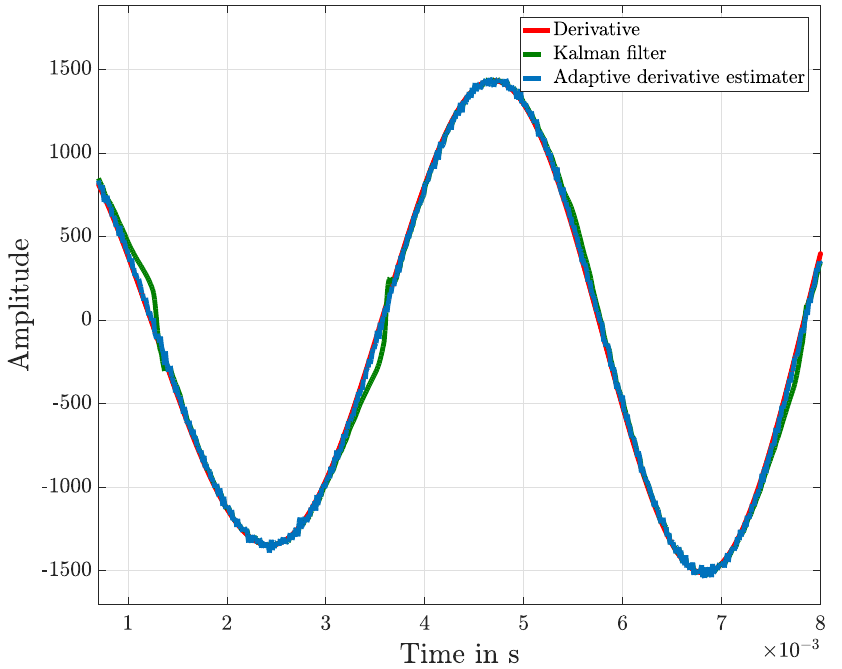
Figure 11. Detailed representation of the low-frequency part of the chirp input signal and its estimations from Figure